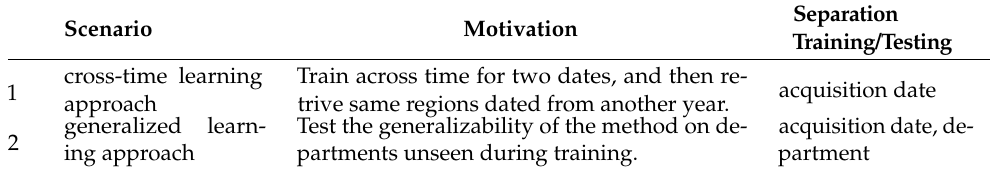
Table 5. Two scenarios used in our